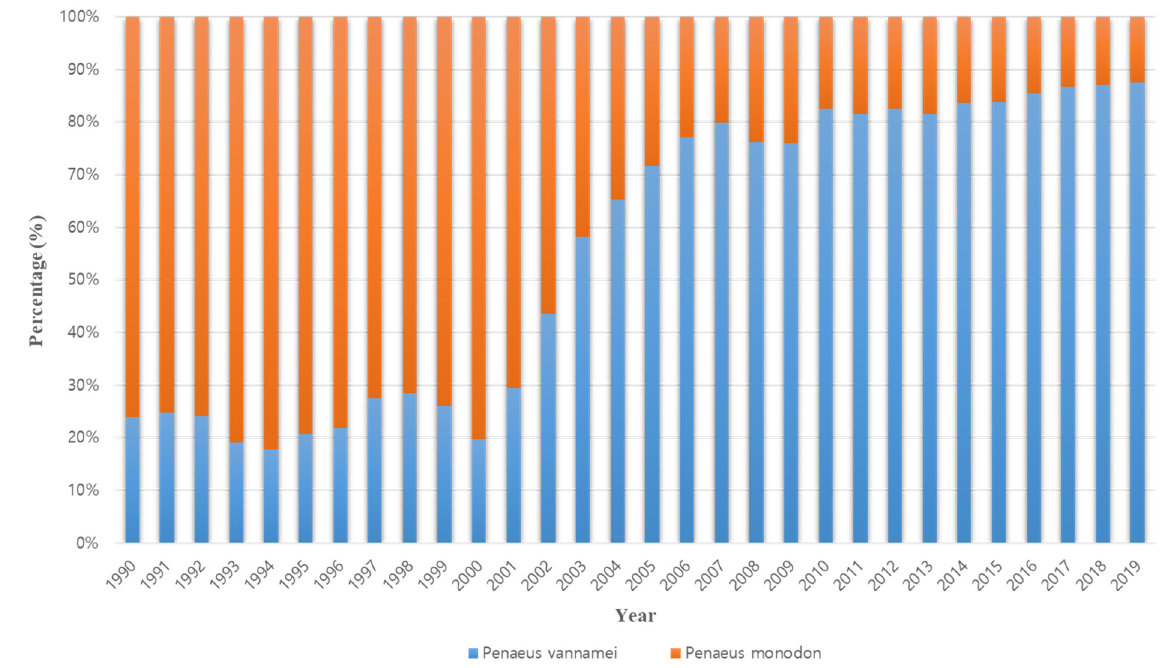
Figure 2. Proportion of the major shrimp species Penaeus monodon and Penaeus vannamei in aquacul- ture production from 1990 to 2019 (Source: FAO yearbook of Fishery and Aquaculture Statistics).